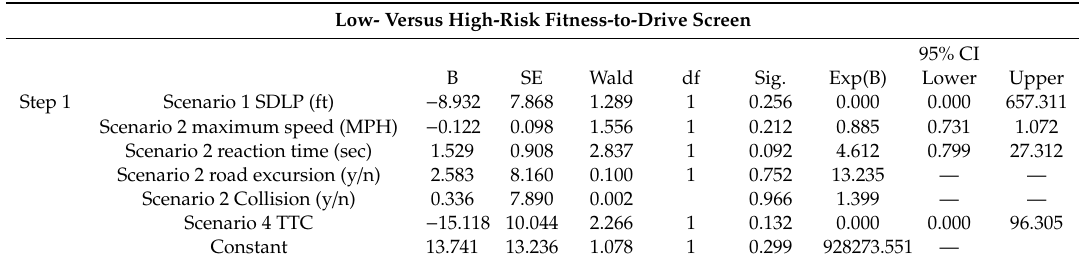
Table 9. Research simulator variables in the binary logistic regression Model 1.